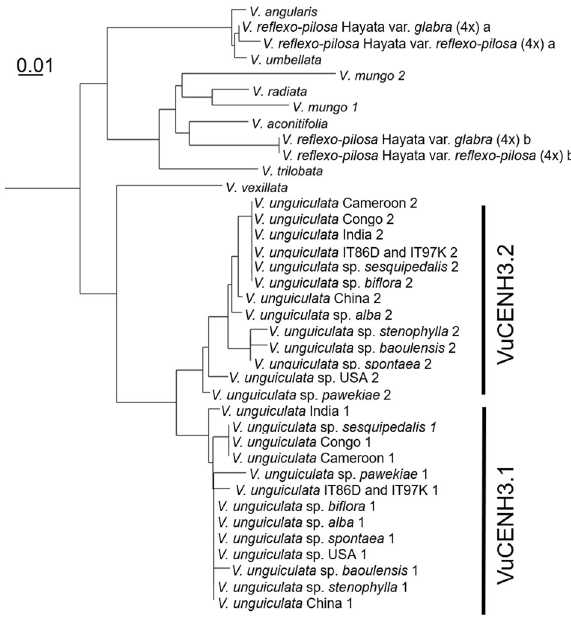
Fig. 1 Phylogenetic tree of Vigna based on CENH3 amino acid sequences. Two variants of CENH3 (VuCENH3.1 and VuCENH3.2) were identi fi ed in all V. unguiculata accessions, diploid V. mungo , and tetraploid species of V. re fl exo-pilosa . Other diploid Vigna species ( V. angularis , V. umbellata ,